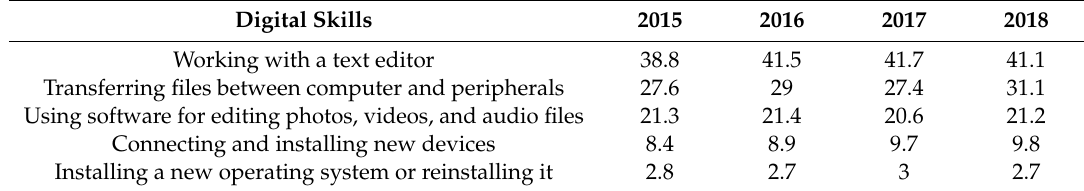
Table 3. Digital skills of the population, in % of the total population aged 15 and over